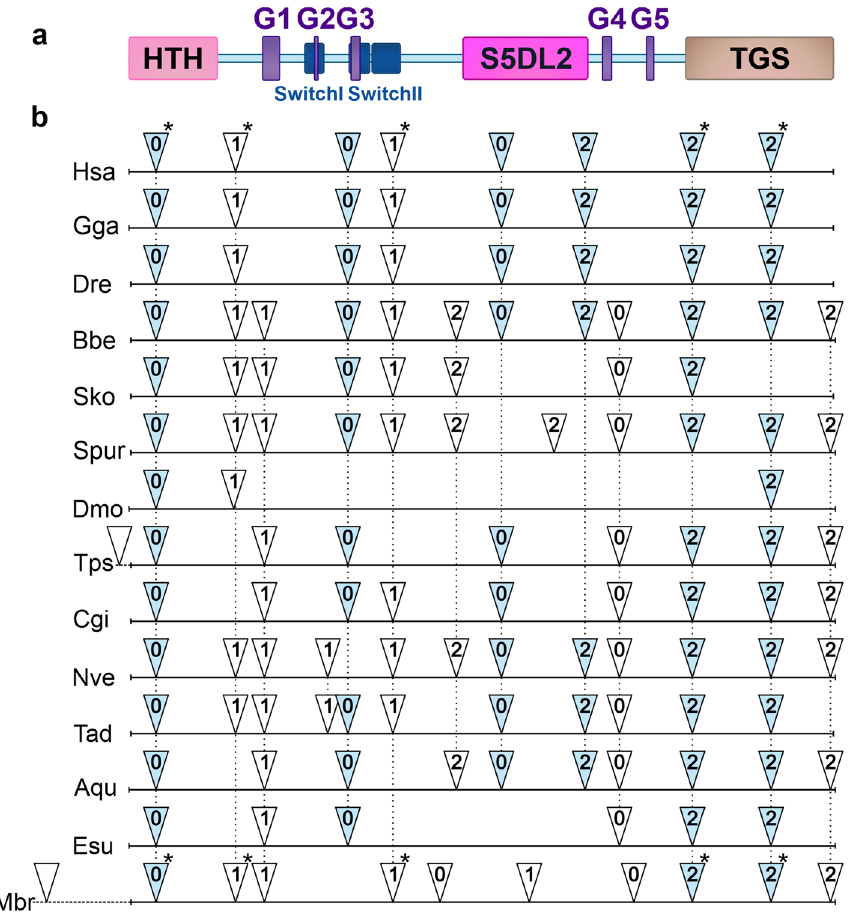
Figure 2. A schematic representation of human DRG1 protein and the positions of introns within drg1 genes. ( a ) DRG1 protein consists of HTH (light pink), S5DL2 (magenta) and TGS (beige) domain, five G-domain motifs (purple) and two switch regions (dark blue). ( b ) Scheme of drg1 genes from the representatives of metazoans and choanoflagellate showing intron positions. The positions of introns are marked by triangles and the number within the triangle denotes the intron phase. Introns that are in the same positions and phases based on the alignment of amino acid sequences are represented by black dashed lines. Introns present in human drg1 gene and choanoflagellate homolog are marked with an asterisk, and those conserved from sponges to human are indicated by light blue color. Sequences of genes with indicated intron positions were taken from the NCBI’s genomic database (https:// www. ncbi. nlm. nih. gov/